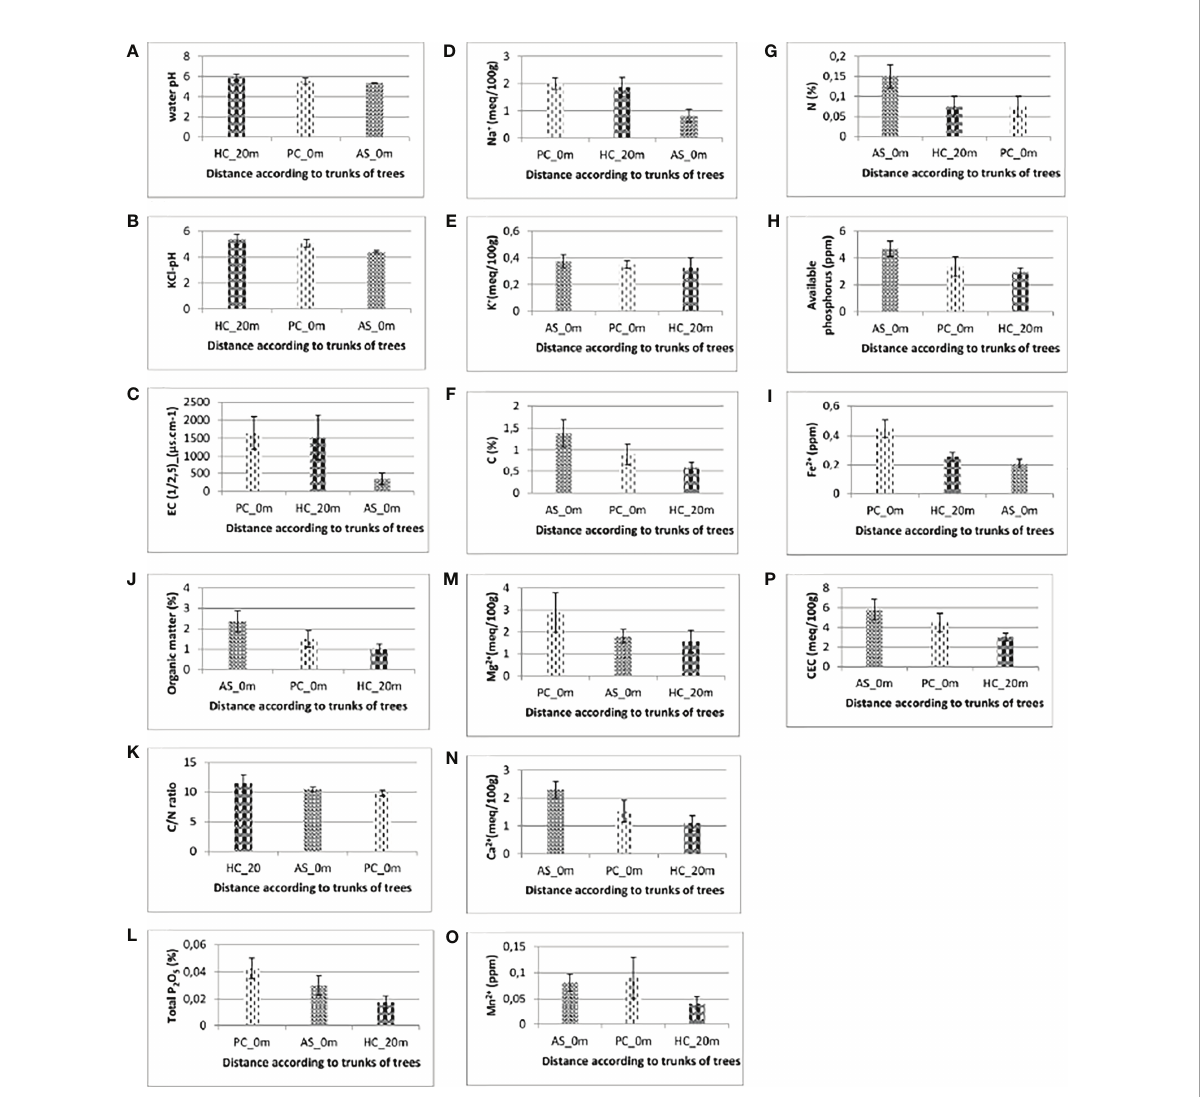
FIGURE 1 Soil water pH (A) , KCl-pH (B) , electrical conductivity (C) , sodium content (D) , potassium content (E) , percentages of carbon (F) , nitrogen content (G) , available phosphorus (H) , iron Fe2+ content (I) , organic matter content (J) , C/N ratio (K) , Total P2O5 content (L) , magnesium content (M) , calcium content (N) , manganese content (O) and cation exchange capacity (P) of soils.AS, Vachellia seyal; Pc, Prosopis chilensis; HC, out cover of